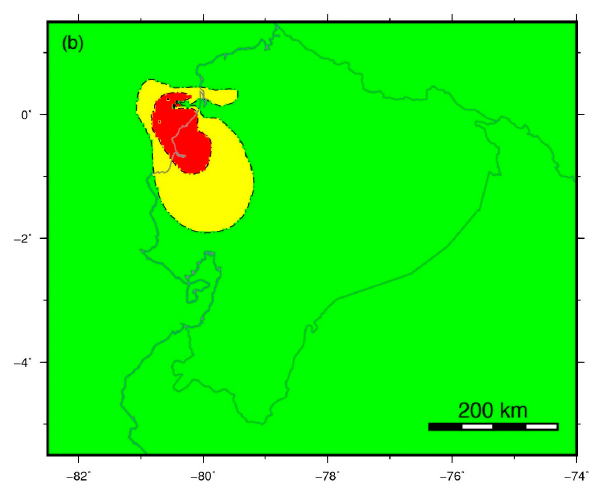
Figure 7. ( a ) Map of potentially activated mapped faults of Ecuador. Coloured segments correspond to fault traces from [50]. Colours green–yellow–red indicate the level of potential activation of the fault segment by the Pedernales earthquake. Faults traces labelled X 1 and X 2 are discussed in Section 5.1; ( b ) Map of potentially activated continental faults.